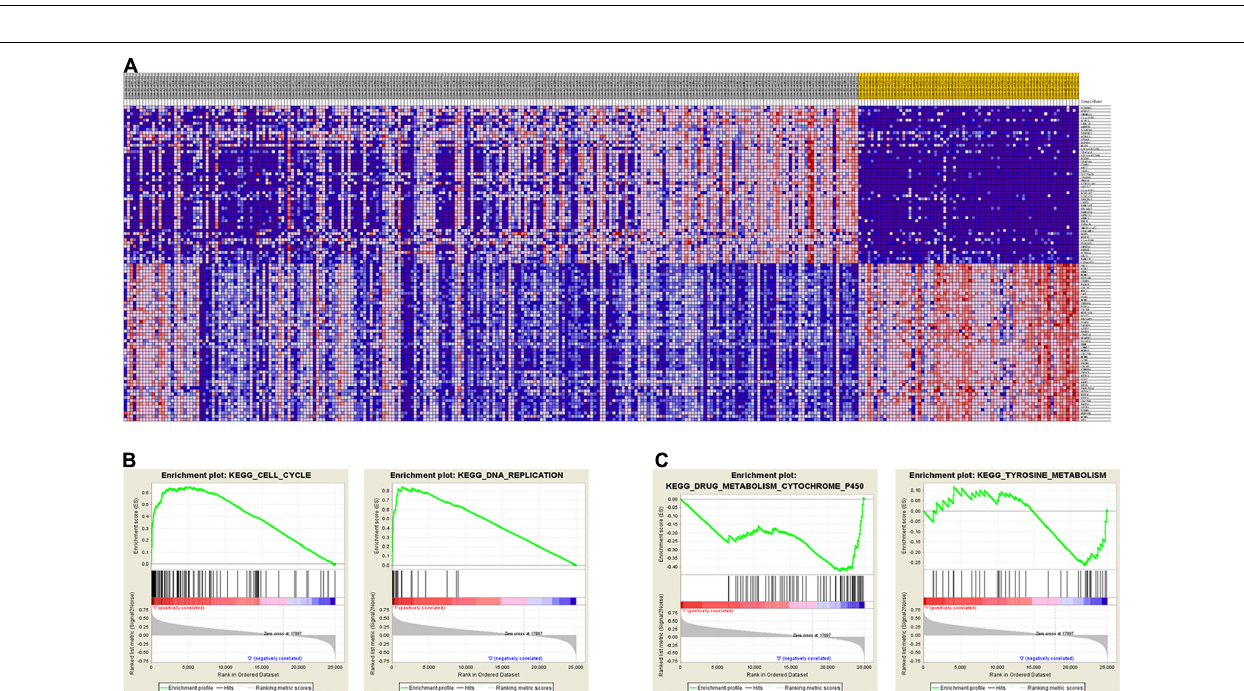
FIGURE 5 | GSEA shows different gene expression signatures in distinct EAC molecular subtypes. (A) Different gene expression patterns in subtype I and subtype II, overexpressed genes shown in Red and downexpressed genes shown in blue. (B) GSEA demonstrated cell cycle and DNA replication pathways in subtype I. (C) GSEA showed enhanced activity of ribosome and drug metabolism cytochrome P450 and tyrosine metabolism in subtype II.